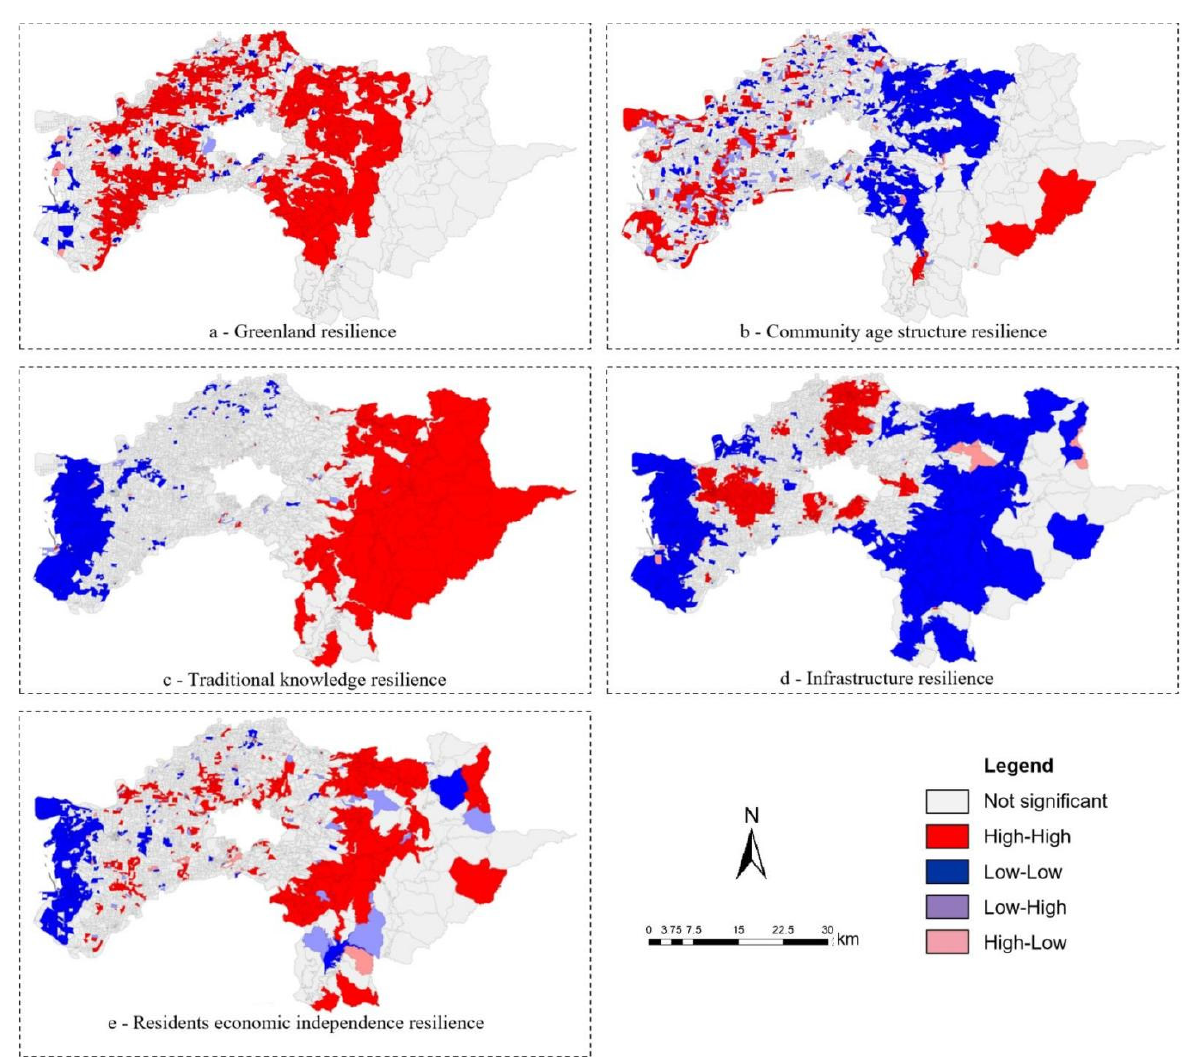
Figure 3. Spatial distribution mode of resilience abilities.